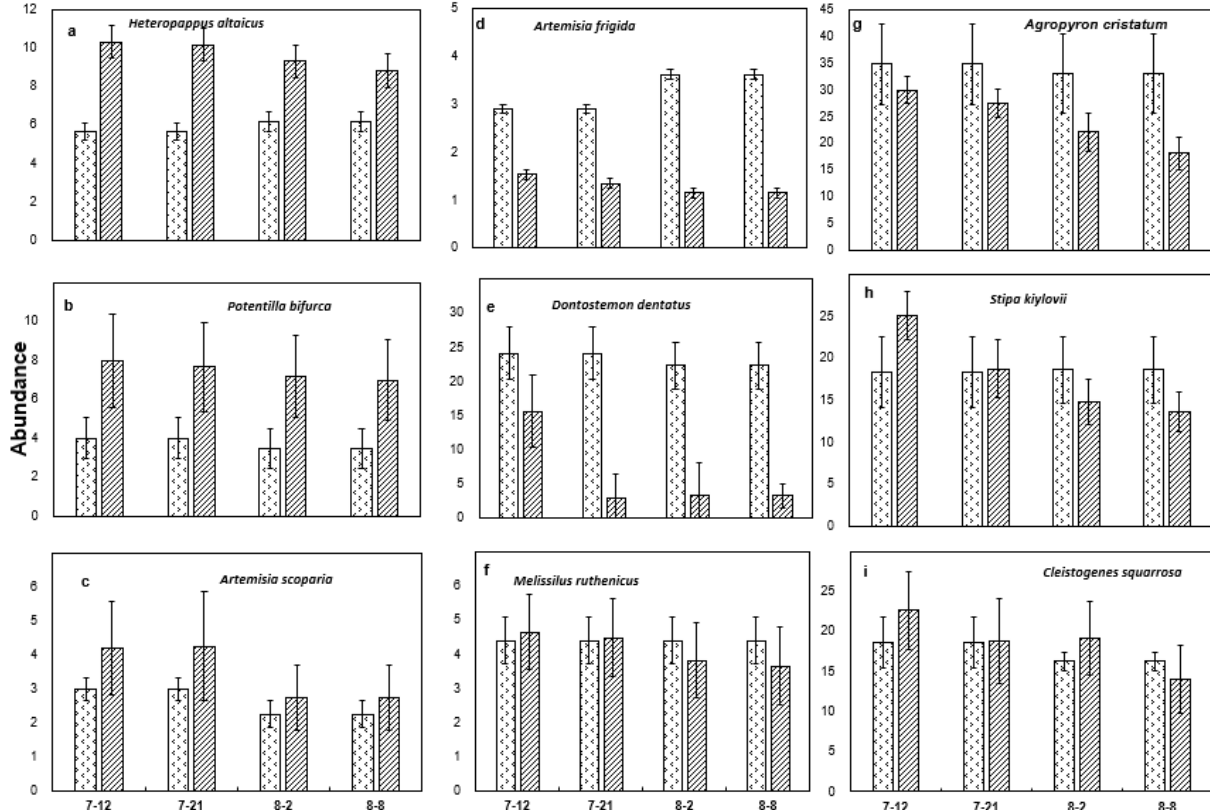
Figure 3. Effects of drought on abundance of Heteropappus altaicus ( a ), Potentilla bifurca ( b ), Artemisia scoparia ( c ), Artemisia frigida ( d ), Dontostemon dentatus ( e ), Melissilus ruthenicus ( f ), Agropyron cristatum ( g ), Stipa kiylovii ( h ), and Cleistogenes squarrosa ( i ). The column with grid and slash represents the control and drought treatment, respectively. See Figure 2 for abbreviations and graph information.